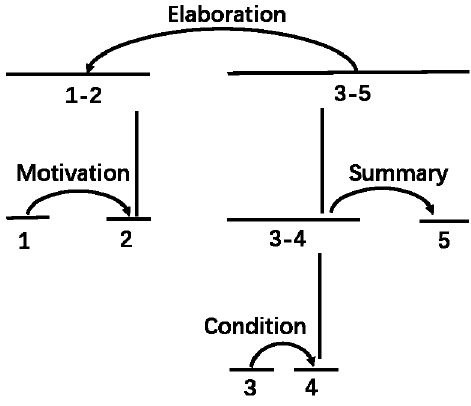
Figure 1. Diagram of an RST analysis.